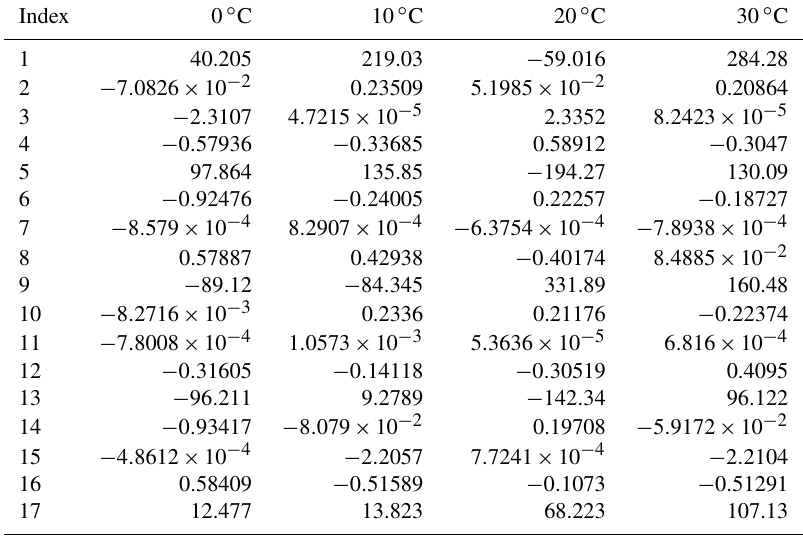
Table A3. Coefficients c 1 − 17 for A in Eq. (3). The coefficients were calculated for a 30 ◦